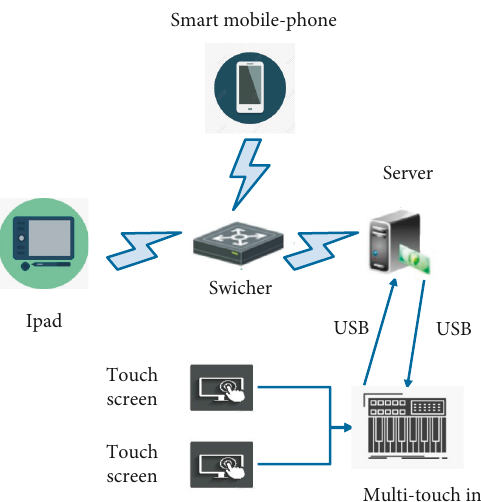
Figure 7: System hardware deployment